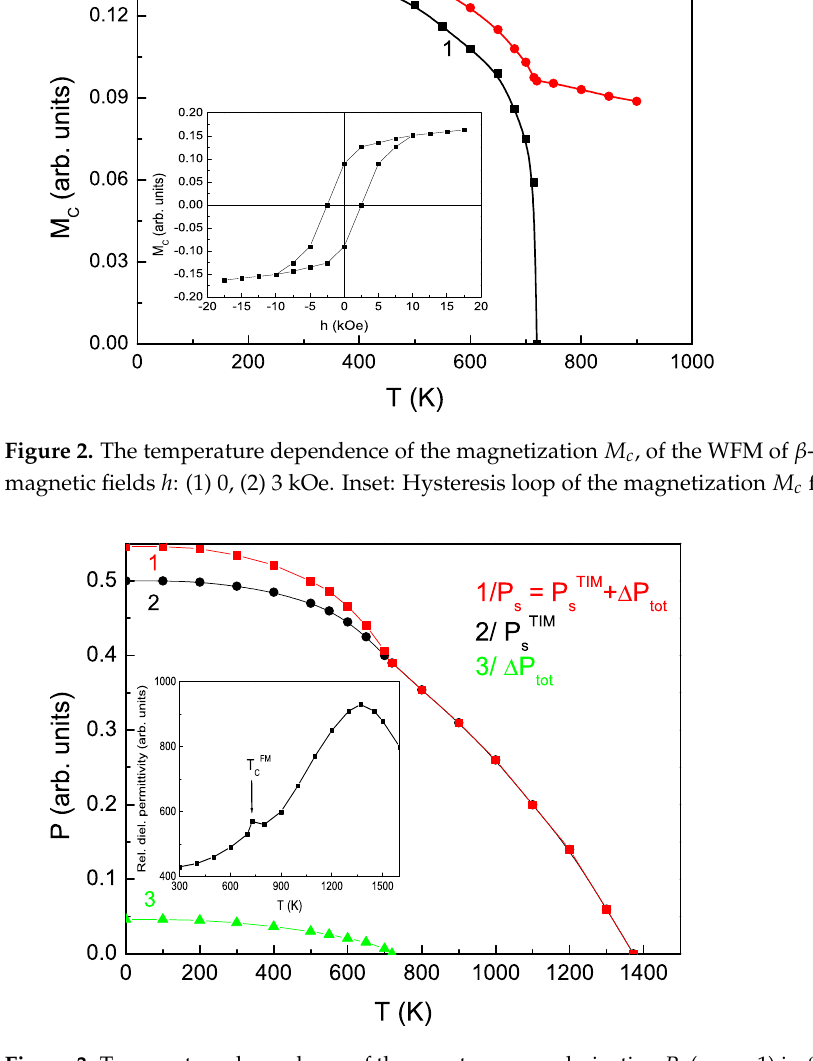
Figure 3. Temperature dependence of the spontaneous polarization P s (curve 1) in β -NFO as a sum of P TIM s (curve 2), calculated from the transverse Ising model, and ∆ P tot (curve 3), observed considering the ME interactions. Inset: Temperature dependence of the relative dielectric permittivity (cid:101) with a kink at T FM C